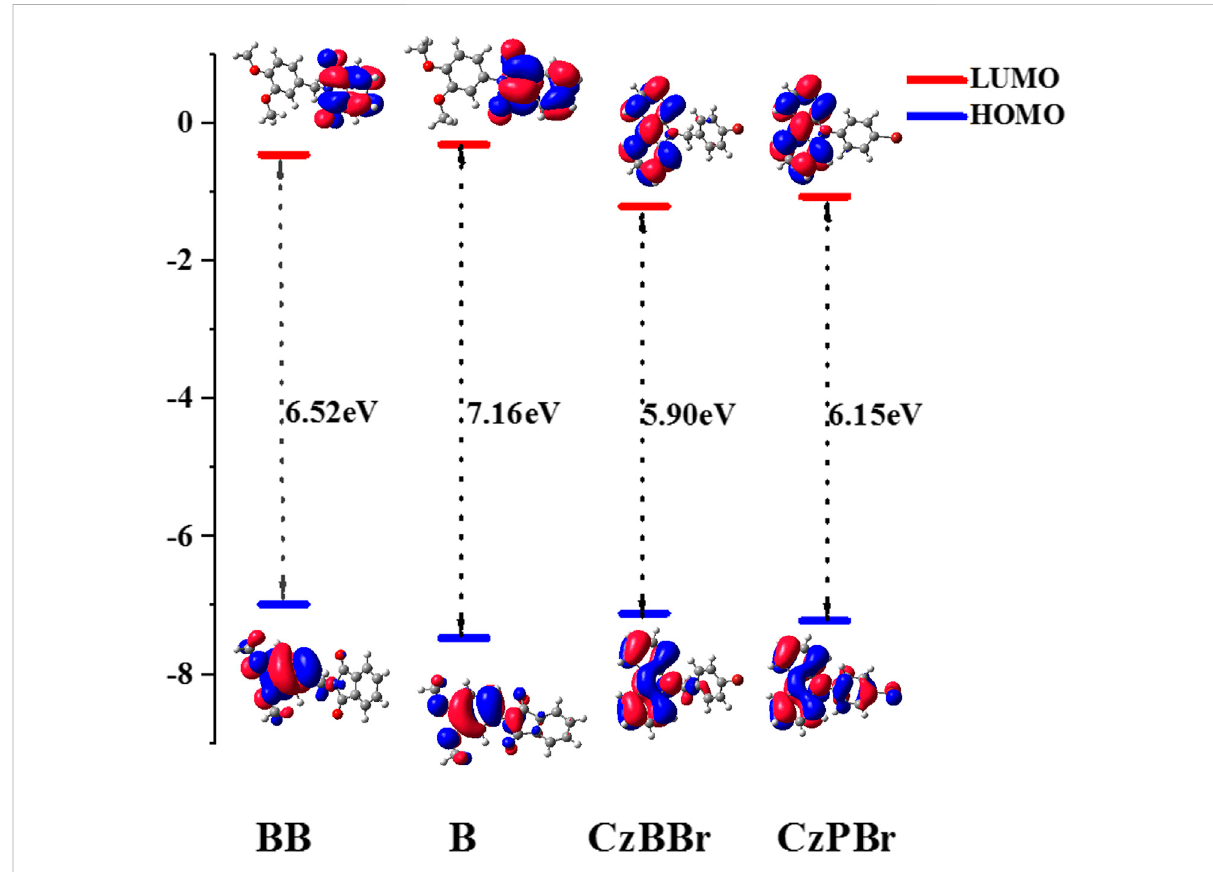
FIGURE 3 The HOMO and LUMO orbital diagram and energy gap of studied